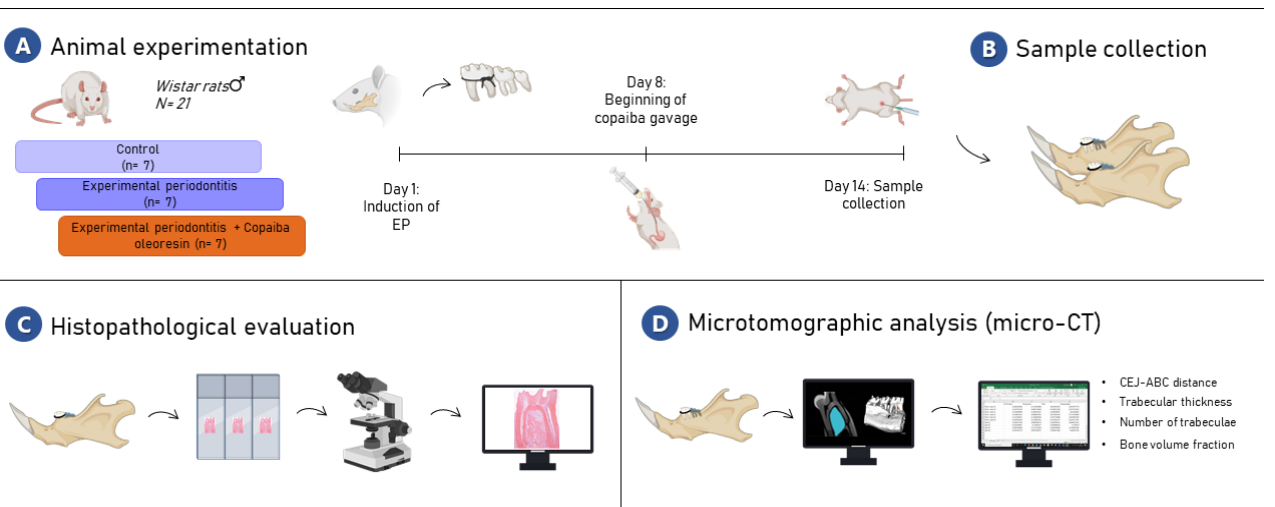
Figure 6. The geographical location of the town Belterra in the state of Pará, Brazil.